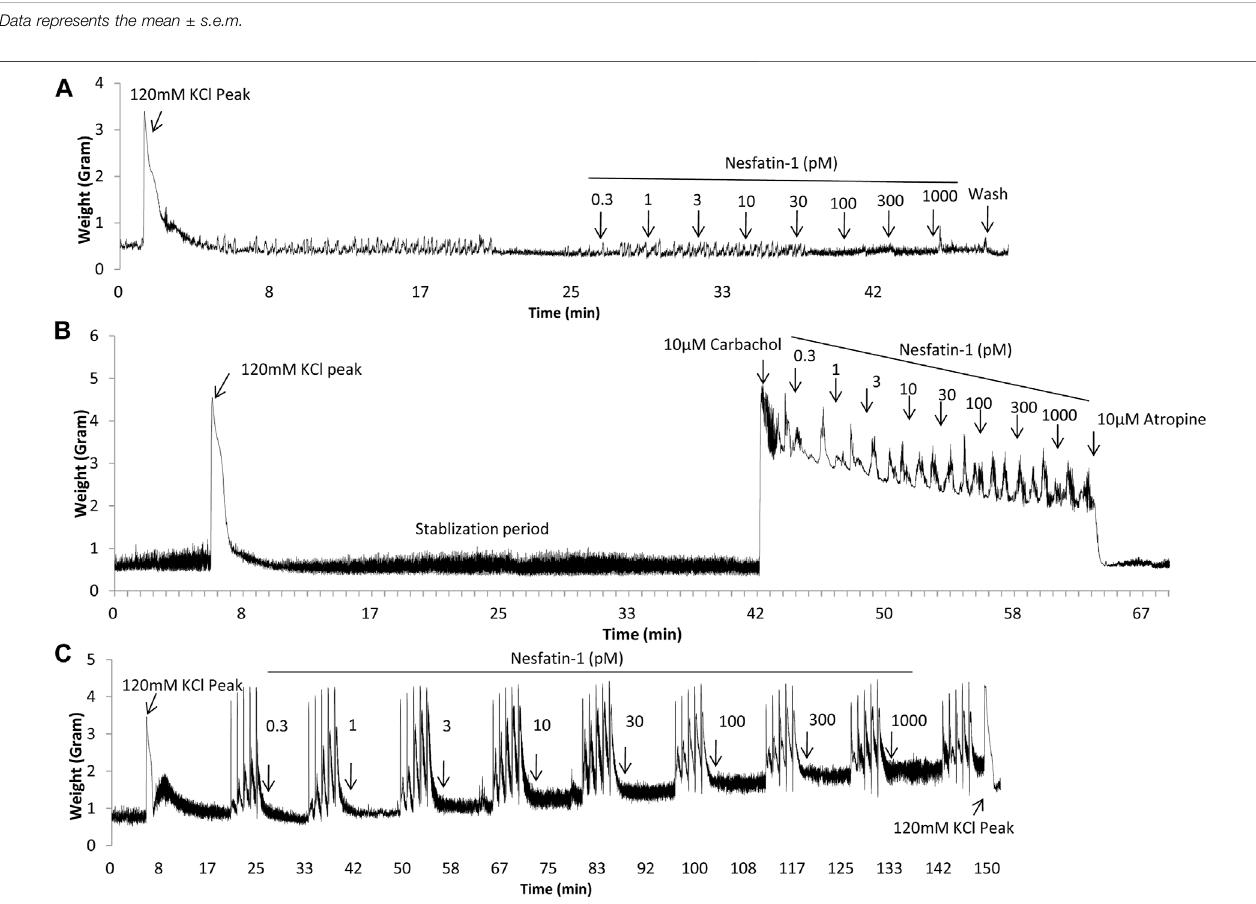
FIGURE 4 | Representative tracings illustrating the contractile responsiveness of Suncus murinus duodenal segments to nesfatin-1, carbachol, electrical fi eld stimulation (EFS) and atropine. (A) Effect of nesfatin-1 (0.3 – 1,000 pM), (B) effect of nesfatin-1 (0.3 – 1,000 pM) on the carbachol (10 μ M) pre-contracted duodenal segments, and (C) effect of nesfatin-1 (0.3 – 1,000 pM) and atropine (10 μ M) on the EFS pre-contracted (2, 4, 8, 16, 32 Hz with 1 min interval) duodenal segments.